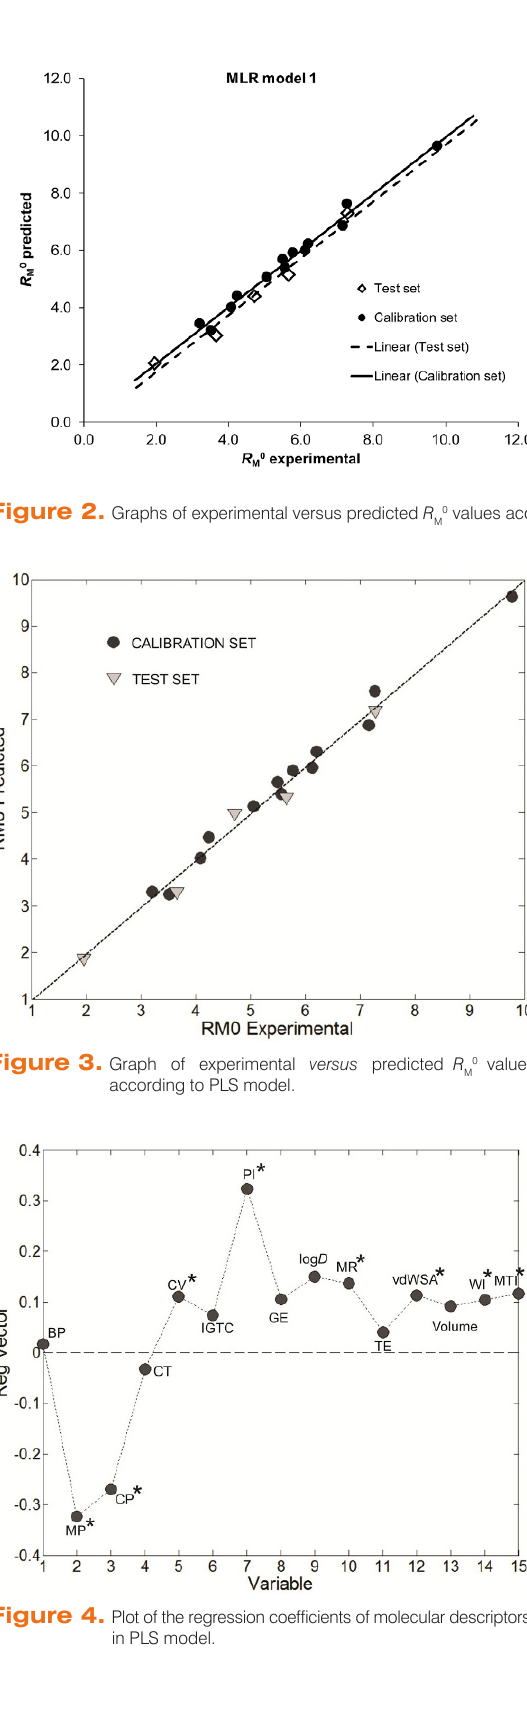
Figure 4. Plot of the regression coefficients of molecular descriptors in PLS